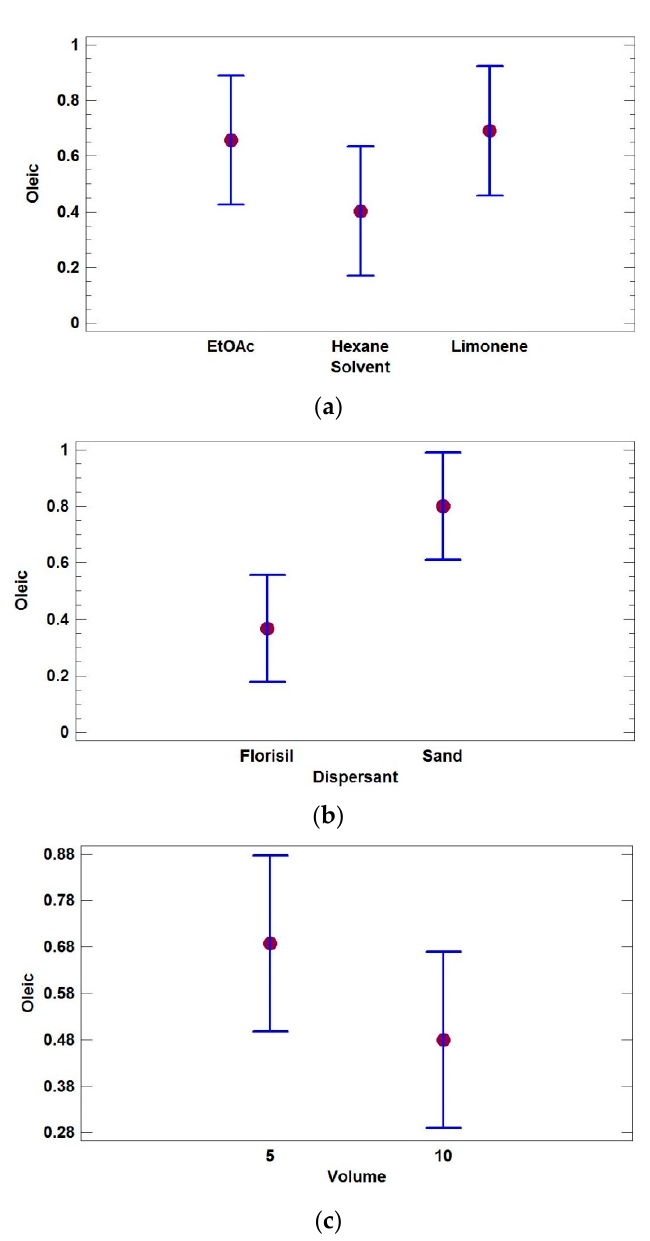
Figure 2. Mean plots of the main factors studied in the multi-factor categorical design for oleic acid: ( a ) extraction solvent; ( b ) dispersant type; ( c ) eluting volume.